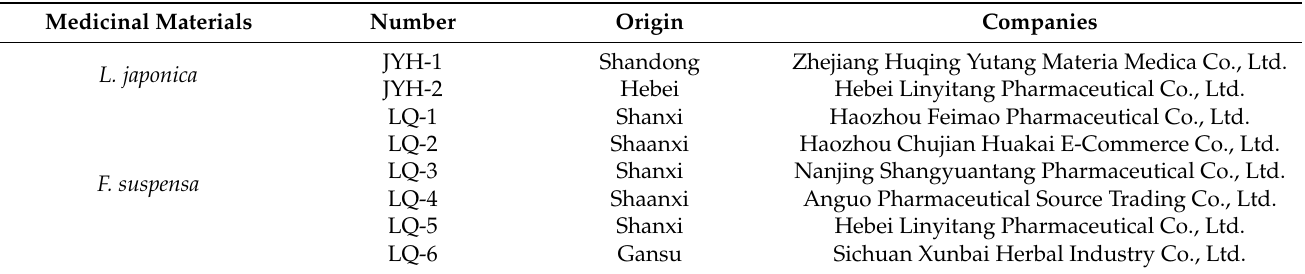
Table 2. Origin and batch information of medicinal